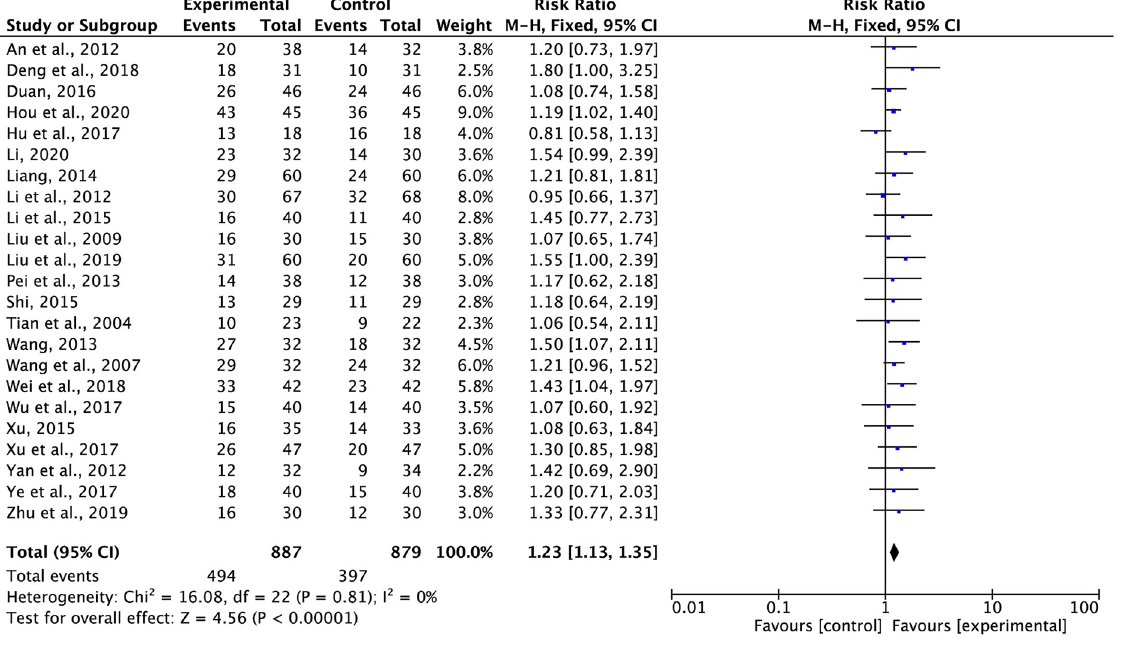
Fig 3. Meta-analysis results of ORR.